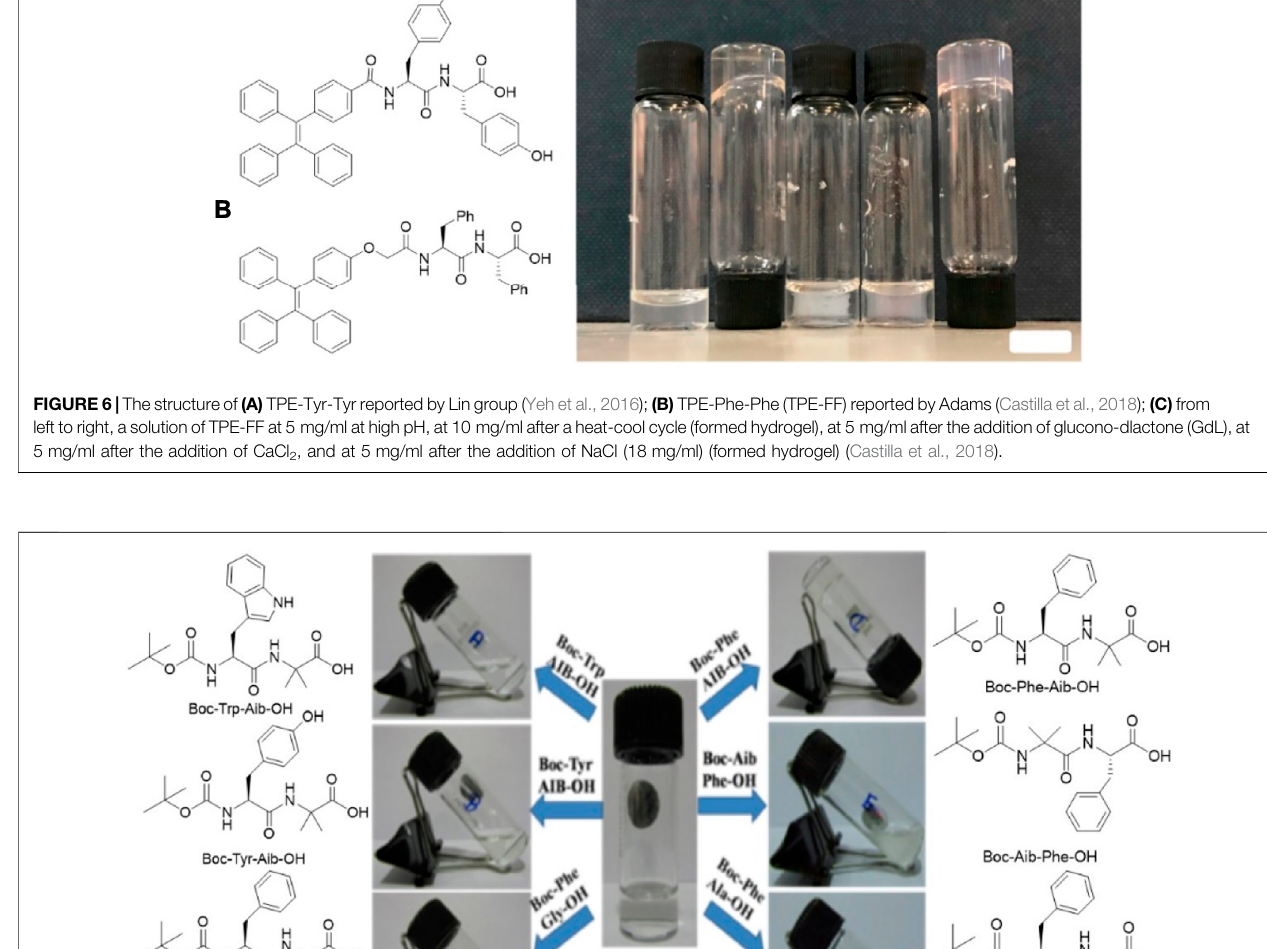
Frontiers in Chemistry |